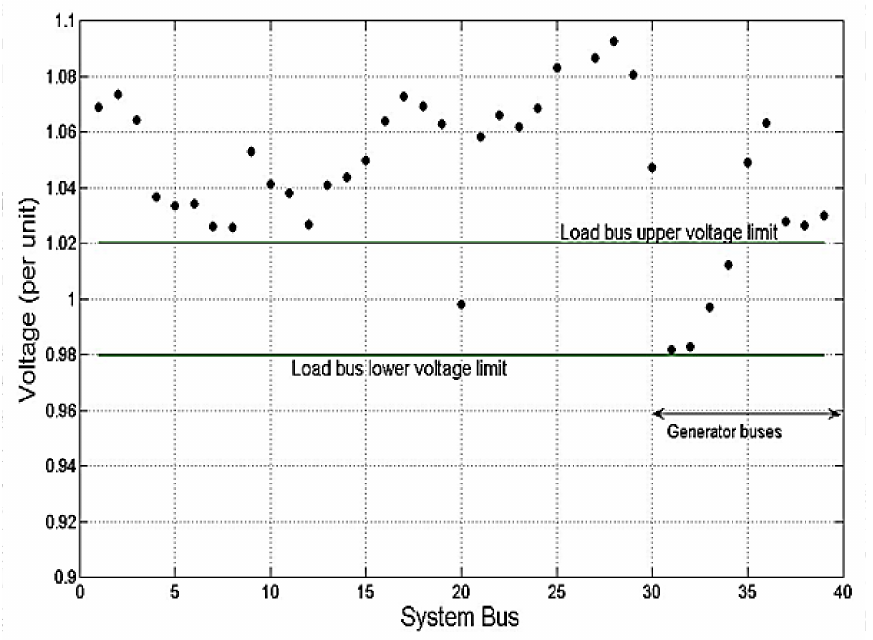
Figure 6. The base voltage profile for the 39-bus